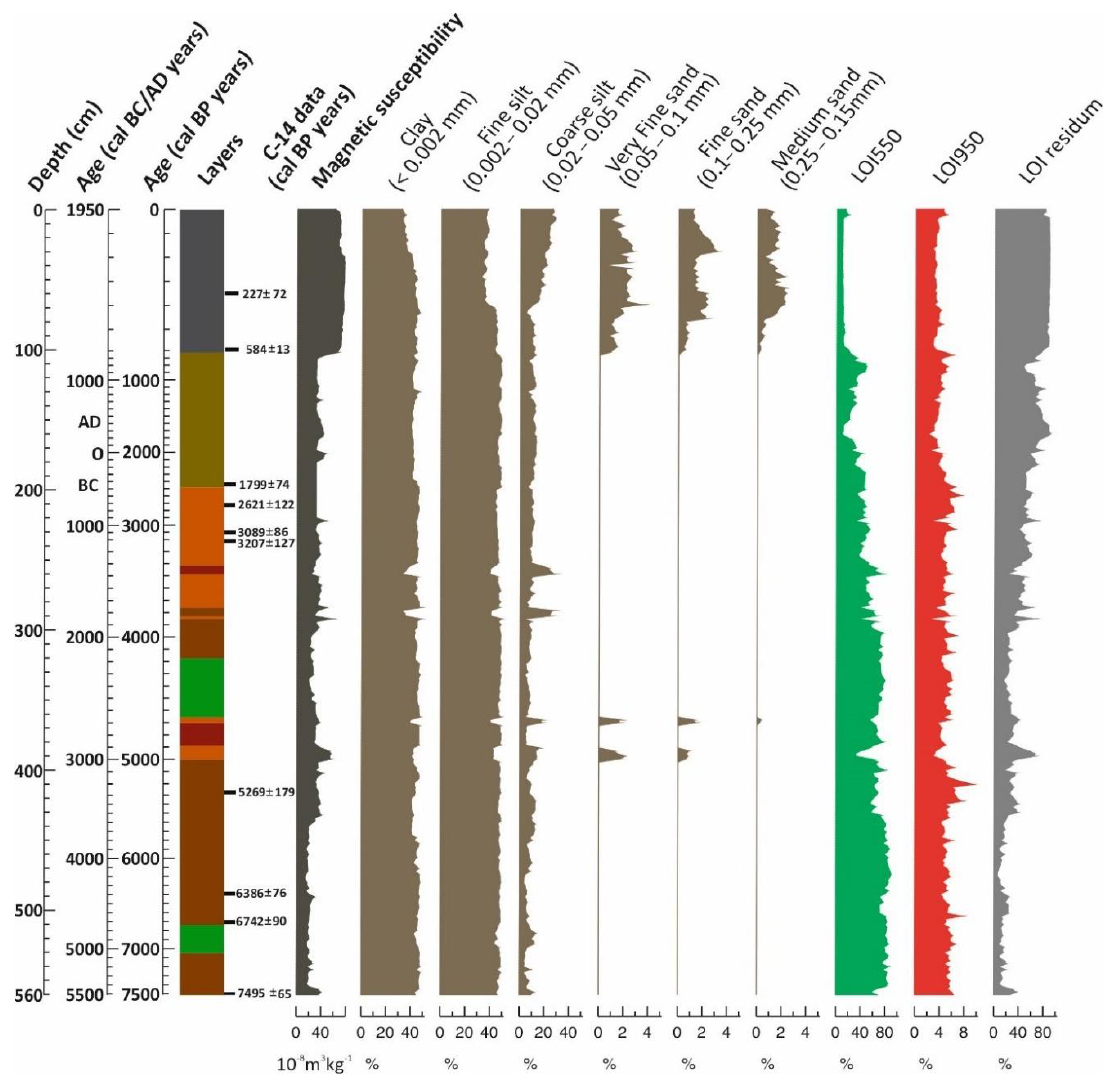
Figure 4. Magnetic susceptibility, grain size and loss on ignition of the Round Lake at Homoródszentpál (Sânpaul, Roma- nia).